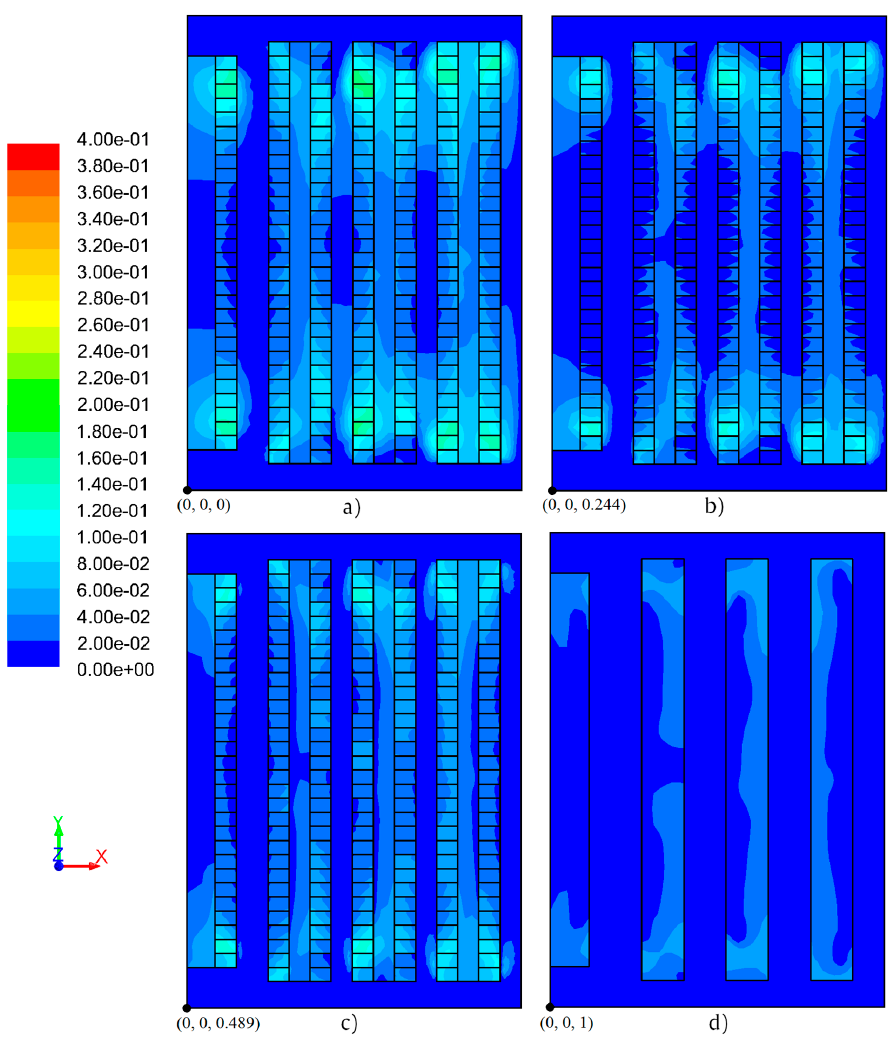
Figure 20. The results of the field of temperature in the x–y plane through the planes: ( a ) z adm = 0; ( b ) z adm = 0.244; ( c ) z adm = 0.489; and ( d ) z adm = 1.